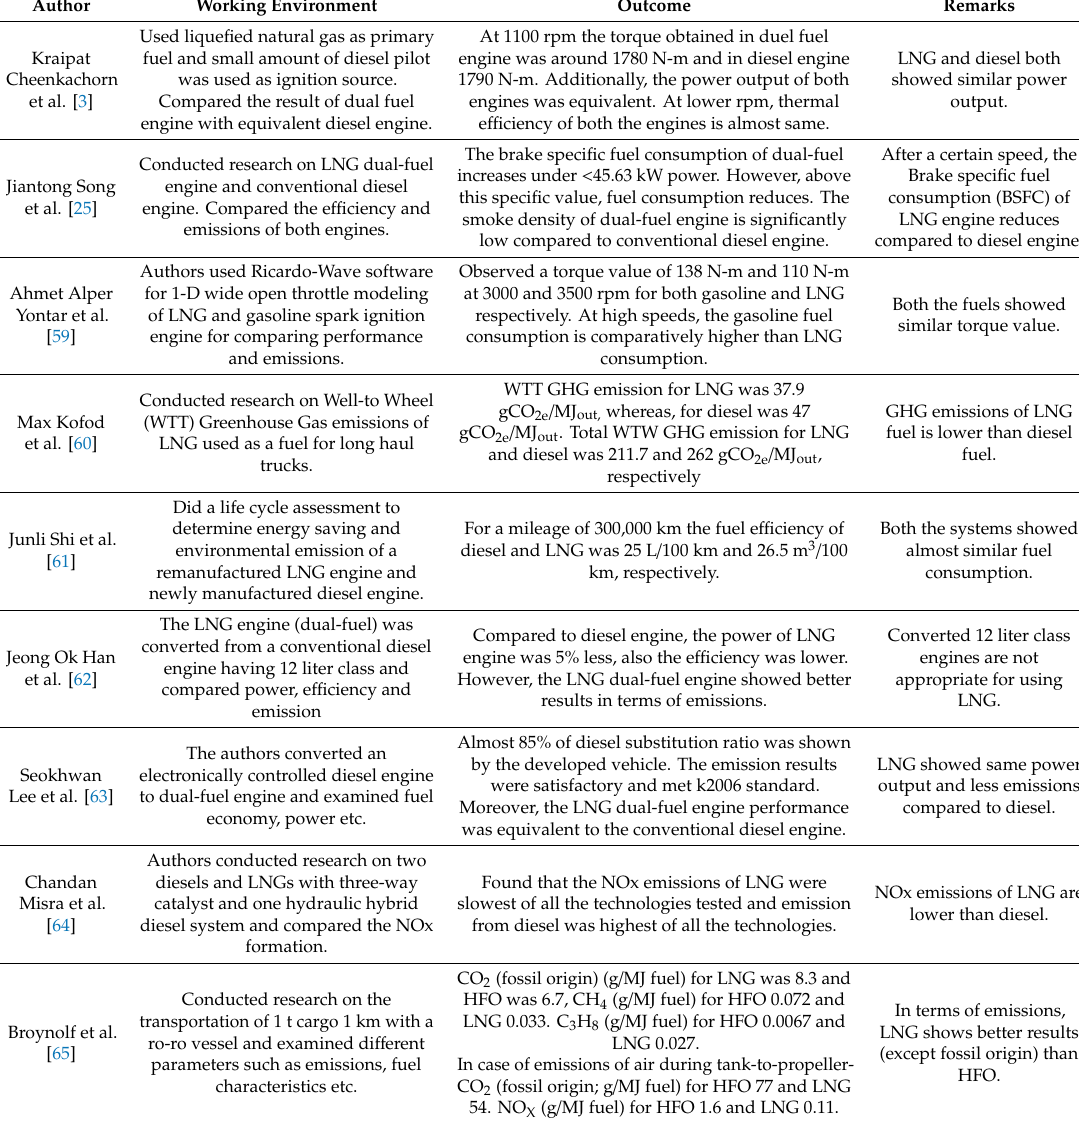
Table 4. Recent research on LNG as a fuel for the diesel